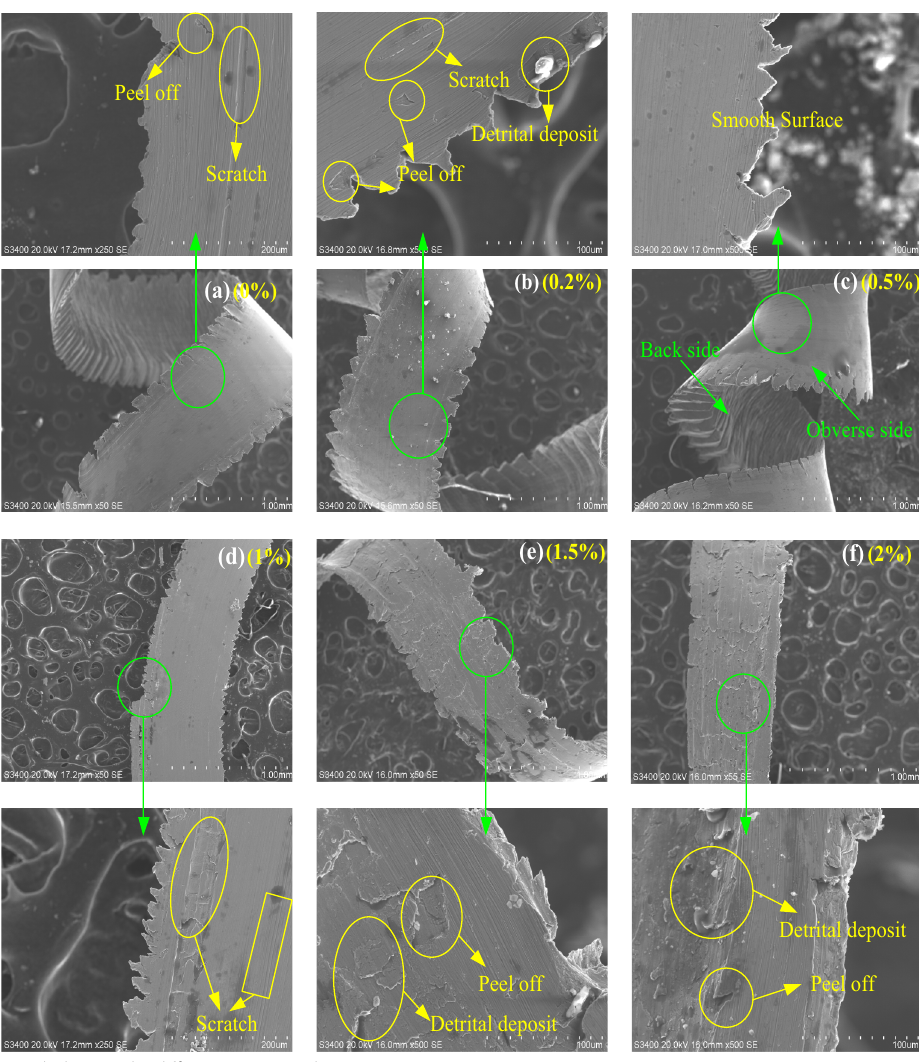
Figure 6 Chip morphology under different nanoparticle concentrations